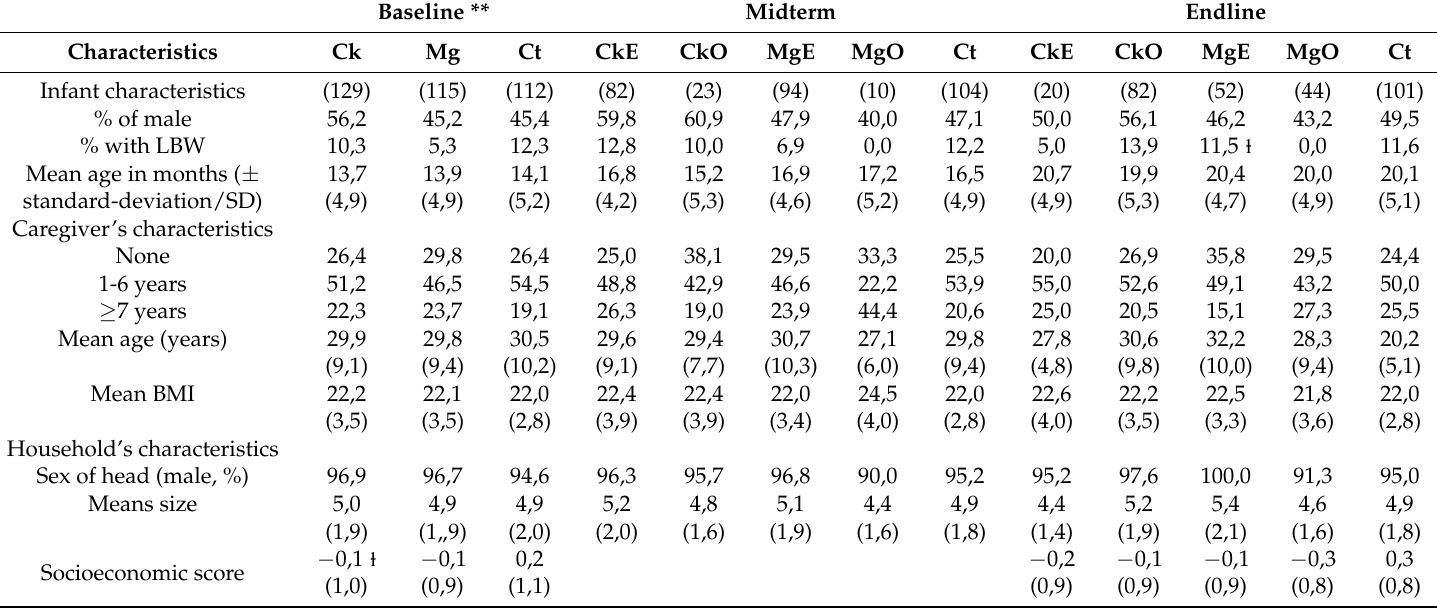
Table 1. Description of the population at baseline, midterm and endline *.